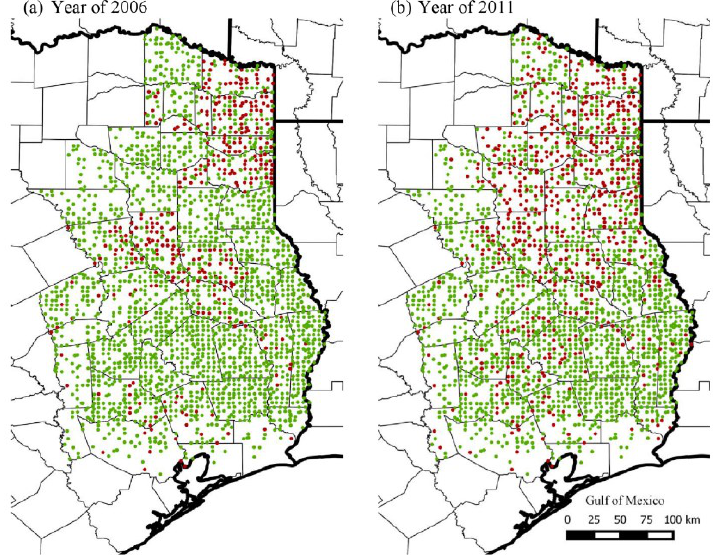
Figure 1. Presence (red dots) and absence (green dots) of Japanese honeysuckle in forested plots sampled in eastern Texas in ( a ) 2006 and ( b ) 2011 as part of the Forest Inventory and Analysis Program of the U.S. Forest Service [25].